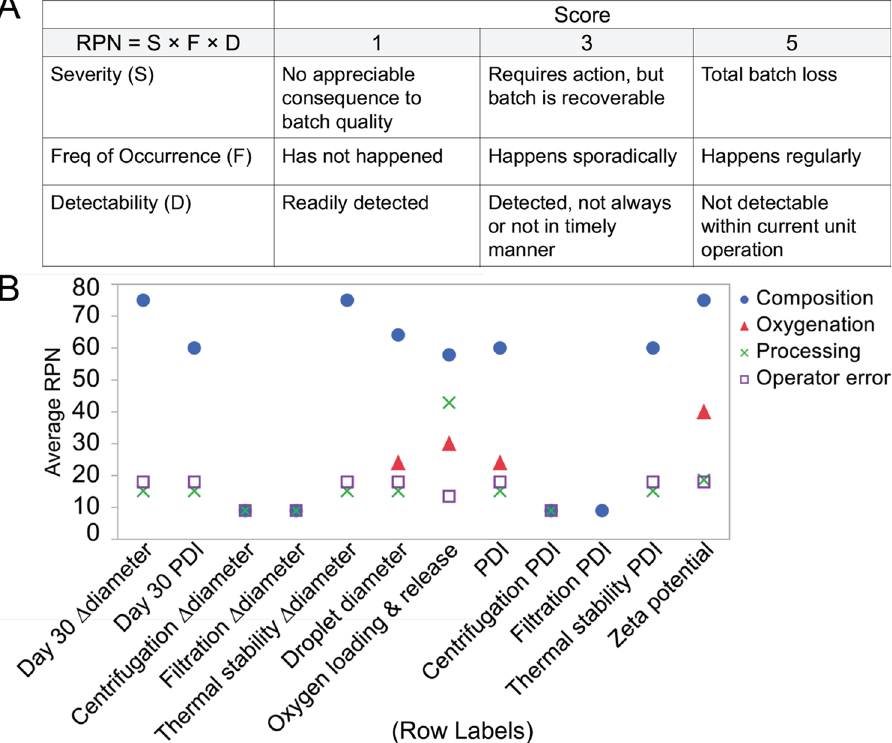
Figure 3. Description and summary of failure mode, effects, and criticality analysis (FMECA) results. ( A ) Definition of Risk Priority Number (RPN) scoring system. Each failure mode in a specified critical quality attribute is assigned scores in each of three categories (Severity, Frequency of Occurrence, and Detectability). RPN is calculated by the product of these individual scores. Scores of 2 and 4 would indicate the failure mode is between 1 and 3, and between 3 and 5, respectively (Microsoft PowerPoint). ( B ) For each critical quality attribute, all failure modes were recorded, and each was classified into one of 4 broad failure modes category (composition, oxygenation, processing, or operator error). All RPN from each failure mode for each CQA in a specified category were averaged to highlight which of the 4 broad failure modes categories were most likely to present challenges in PFC-NE development (JMP